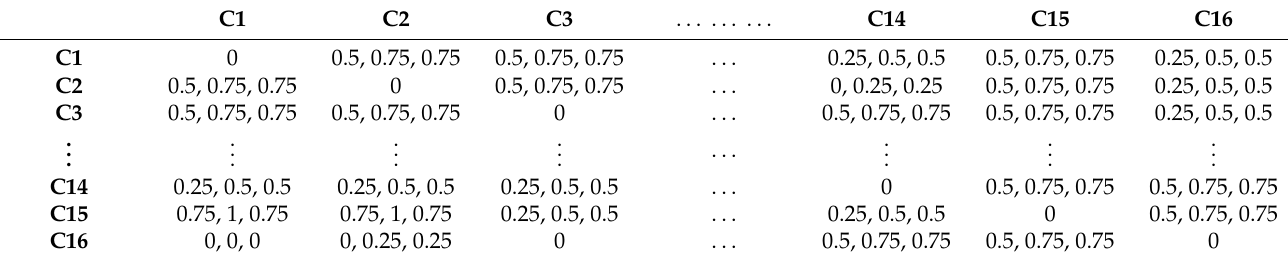
Table 5. Normalized triangular fuzzy numbers.